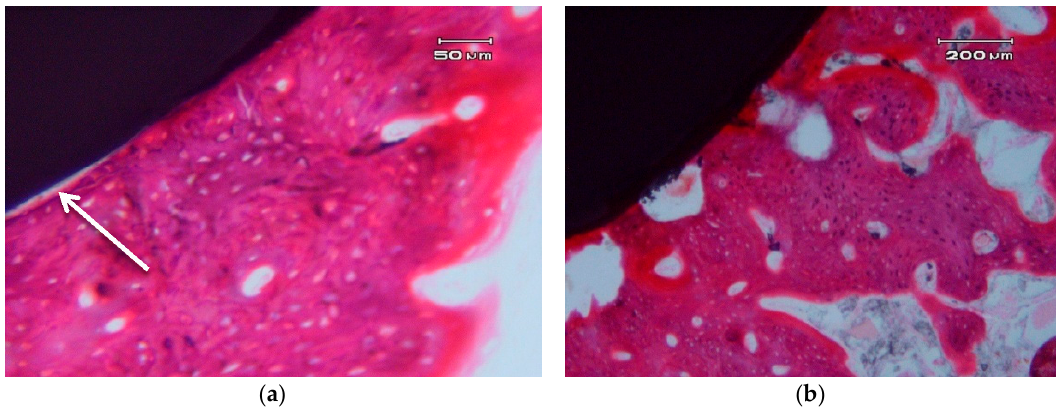
Figure 4. 3D profiles of a ZCE-A implant surface at different angles. ( a ) oblique view and ( b ) front view.